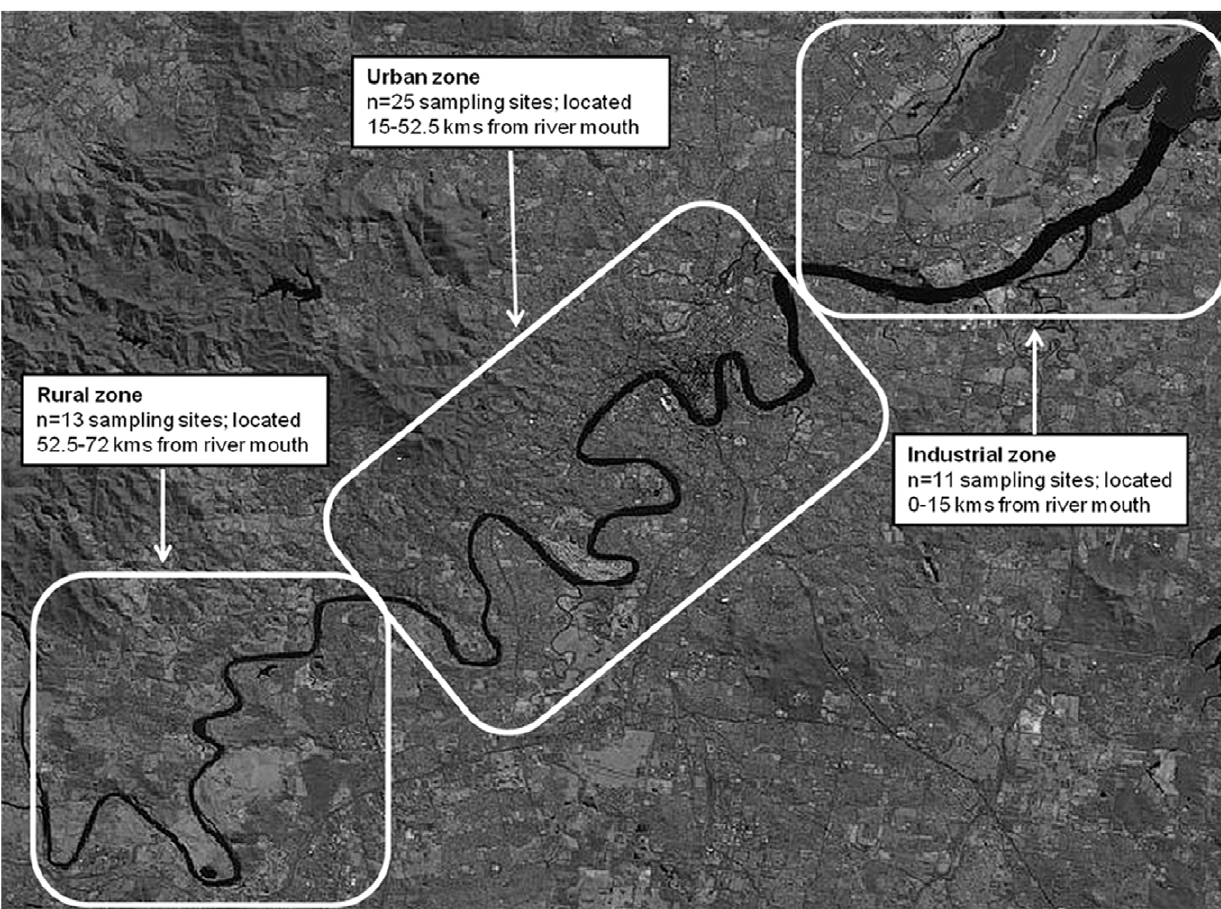
Figure 1. Map (1:136,268) of the Lower Brisbane River showing land use categories.